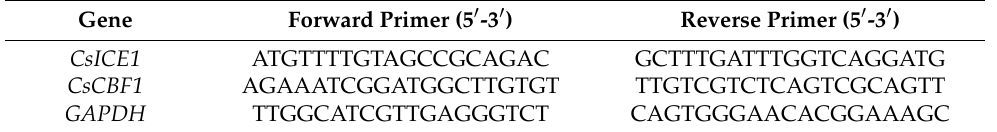
Table 1. The pimer of CsICE1 and CsCBF1 genes expression analysis in tea plant. Gene Forward Primer (5 (cid:48) -3 (cid:48) ) Reverse Primer (5 (cid:48) -3 (cid:48) ) CsICE1 ATGTTTTGTAGCCGCAGAC GCTTTGATTTGGTCAGGATG CsCBF1 AGAAATCGGATGGCTTGTGT TTGTCGTCTCAGTCGCAGTT GAPDH TTGGCATCGTTGAGGGTCT